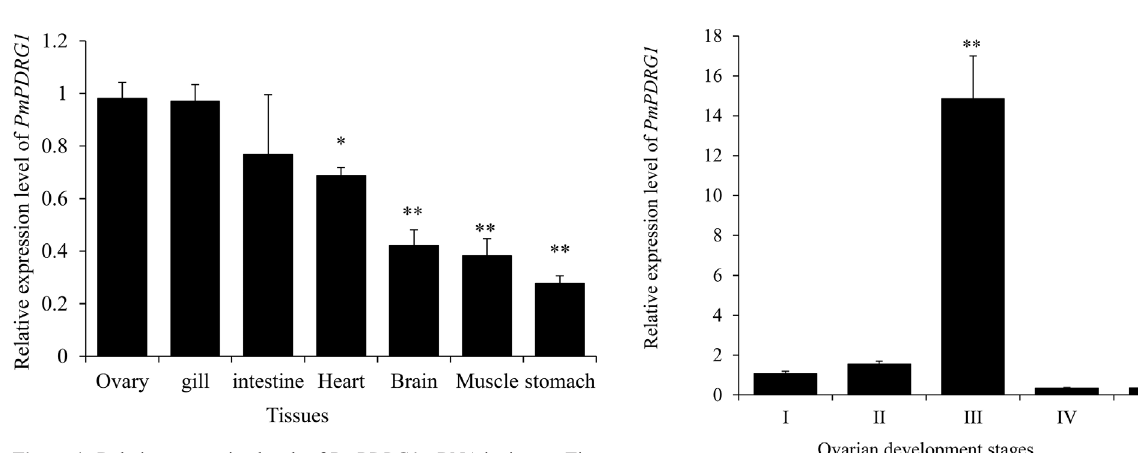
Figure 4 - Relative expression levels of PmPDRG1 mRNA in tissues. Tis- sue distribution of PDRG1 transcripts in the shrimp by RT-qPCR analysis using EF-1 (cid:4) as an internal reference. Vertical bars represented mean (cid:2) SD (n = 5). Significant differences between the experimental and the control group are indicated by asterisks * ( P < 0.05); ** ( P < 0.01).